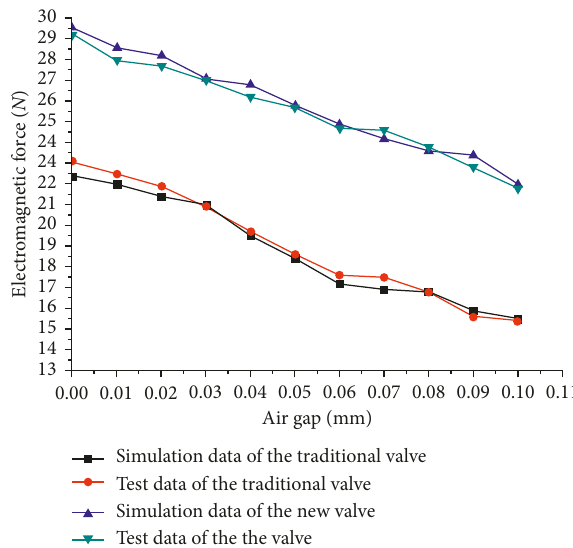
Figure 7: Simulation and testing comparison of electromagnetic force of the two